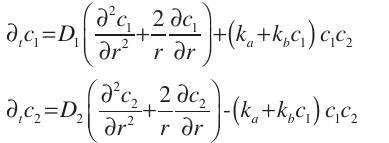
( r ) in 1 = 3.81 × 10 -4 M 10